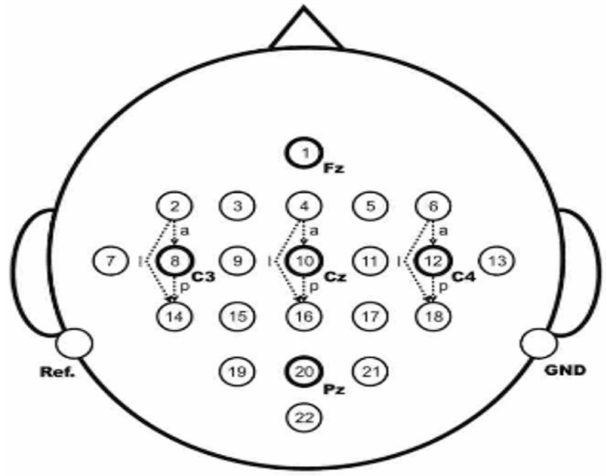
Figure 3. Sample electrode